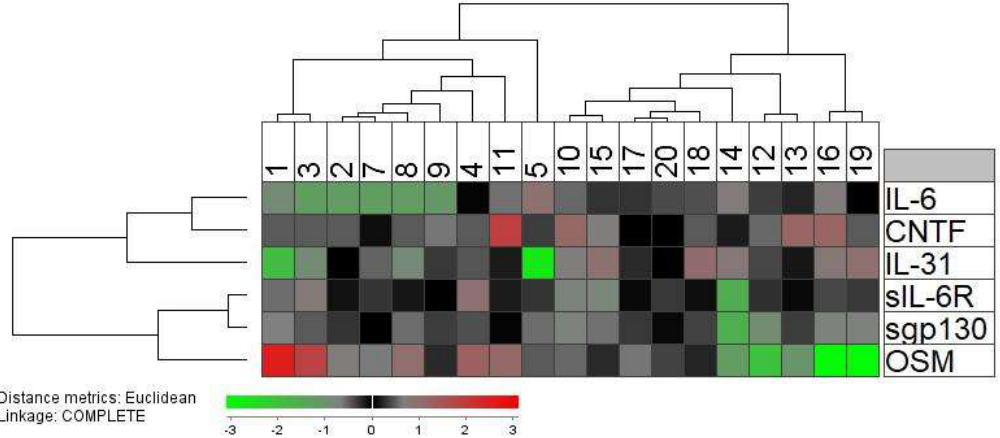
Figure 2. An unsupervised hierarchical clustering analysis of the graft supernatant levels of IL-6 family cytokines/receptors after stem cell mobilization by G-CSF and harvesting by leukapheresis. The analysis included 19 donors because a graft sample was not available for patient 6. The mediator concentrations were normalized to the corresponding median level for each mediator and, thereafter, log2 transformed before an unsupervised hierarchical clustering with Euclidian distance measurement and complete linkage was performed. The color scale thus corresponds to the Euclidian distance from the median since values were normalized to the corresponding median value, i.e., two measurements with the same color show the same distance from the median. The results are presented as dendrograms and a heat map for visualization and interpretation. The individual donors are indicated at the top of the figure whereas the different mediators are presented vertically in the right part of the figure. Table 3. Serum levels of soluble mediators and their associations with levels of immunocompetent and CD34 + cells in peripheral blood and stem cell grafts. We investigated the levels of six different immunocompetent cell subsets for 20 healthy stem cell donors. Serum levels and levels of circulating cells were determined after four days of G-CSF therapy before apheresis; graft composition was analyzed for the leukapheresis on day 4. For immunocompetent cells the results are presented as the cell number × 10 9 /L in peripheral blood/grafts; for CD34 + cells the levels are presented as the number × 10 3 /mL in peripheral blood and × 10 9 /L in the grafts. Correlation coefficients (Spearman’s rho) between serum levels of IL-6 family cytokines/receptors/CRP and immunocompetent cell subsets in the graft and peripheral blood are also presented. Significant correlations are highlighted in bold (* p -value between 0.05 and 0.01, ** p -value below 0.01).